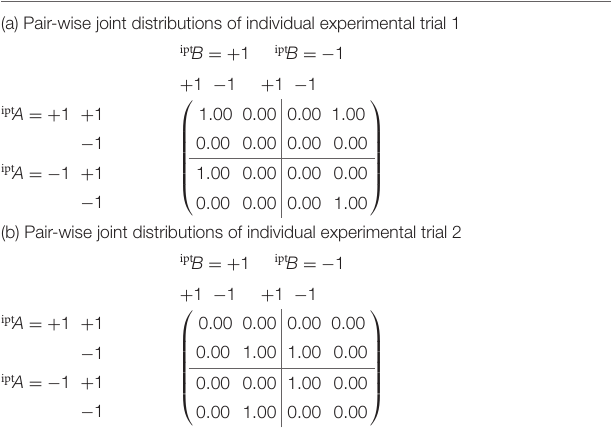
TABLE 4 | Pair-wise joint distributions of combined experimental trials from Table 3